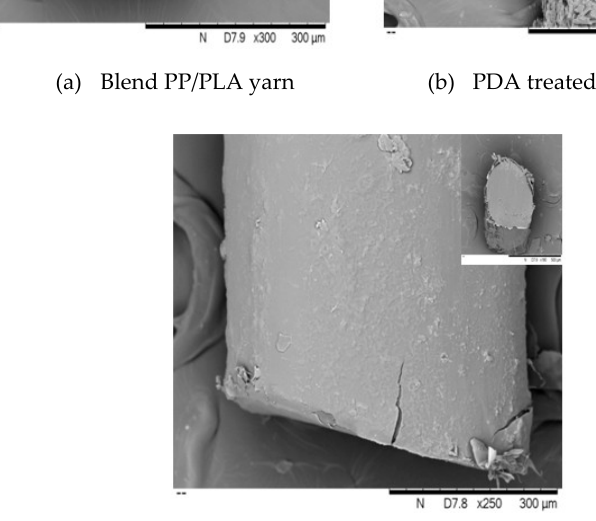
Figure 11. SEM images (surface and cross-section) of PP/PLA yarn at various stages.